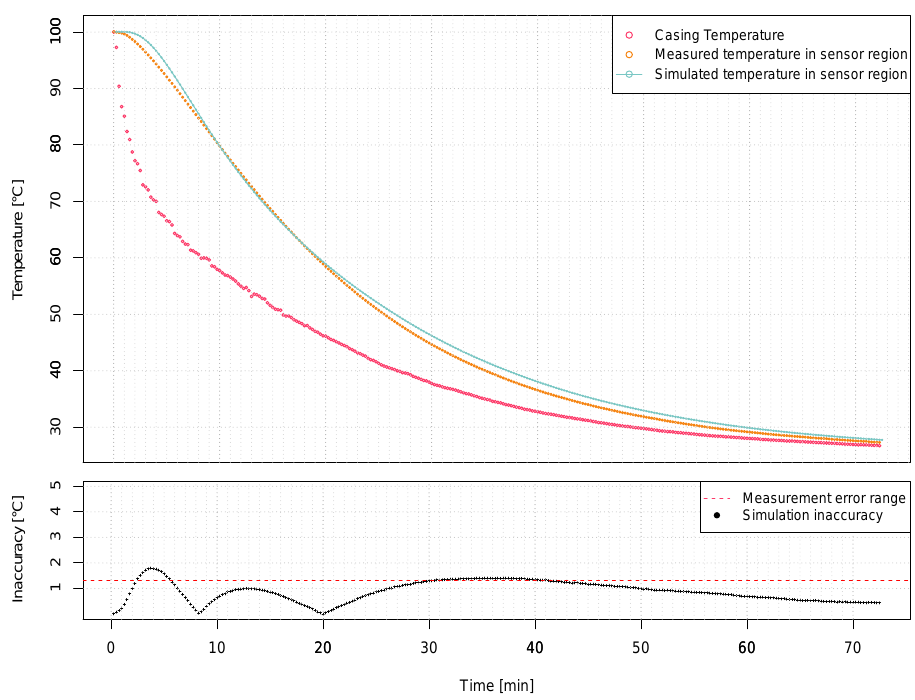
Figure 9. Results of thermal step response of the model and a